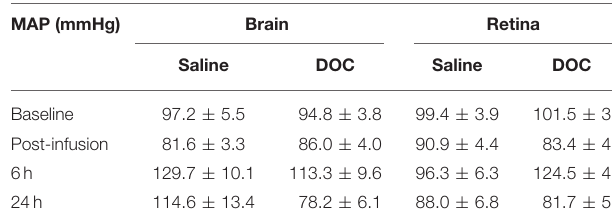
TABLE 2 | Average mean arterial pressure (mmHg) in saline control and DOC groups, at baseline, 6 and 24h after drug administration in the brain and retina